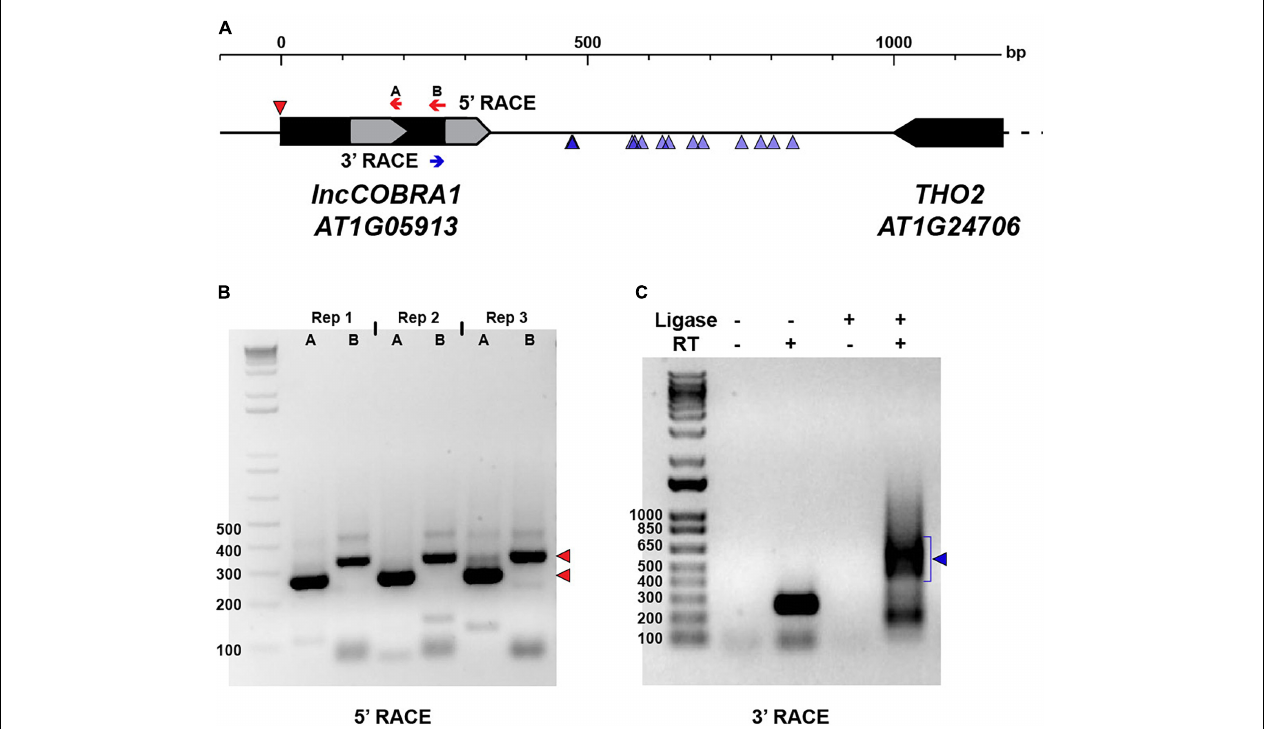
FIGURE 2 | Post-transcriptional processing of lncCOBRA1. (A) Diagram of lncCOBRA1 ( AT1G05913 ) locus. Gray arrows represent the two snoRNAs annotated within lncCOBRA1. Red arrows represent the two primers used for 5 (cid:48) RACE and red triangle represents the 5 (cid:48) end identified by 5 (cid:48) RACE PCR in (B) . Blue arrow represents the primer used for 3 (cid:48) RACE. Blue triangles represent the 3’ most end identified through Sanger sequencing 14 colonies. (B) Three biological replicates of 5 (cid:48) RACE with primers indicated in (B) . Red triangles represent the two major bands of PCR product. Ladder is 1 kb + . (C) PCR results from 3 (cid:48) RACE in Col-0 5-day-old seedlings. –/+T4 RNA ligase, –/+SuperScript II. Ladder is 1 kb